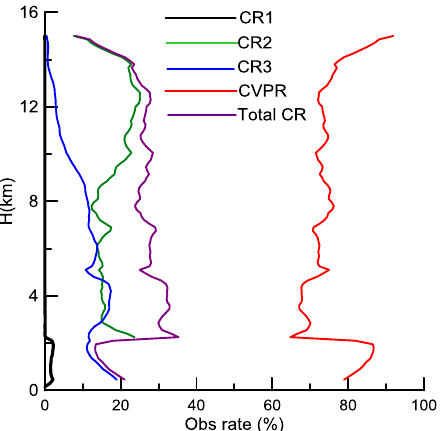
Figure 14. Percentage contributions from CR1 (black), CR2 (green), CR3 (blue), entire CR (purple) and CVPR (red) to the merged reflectivity.